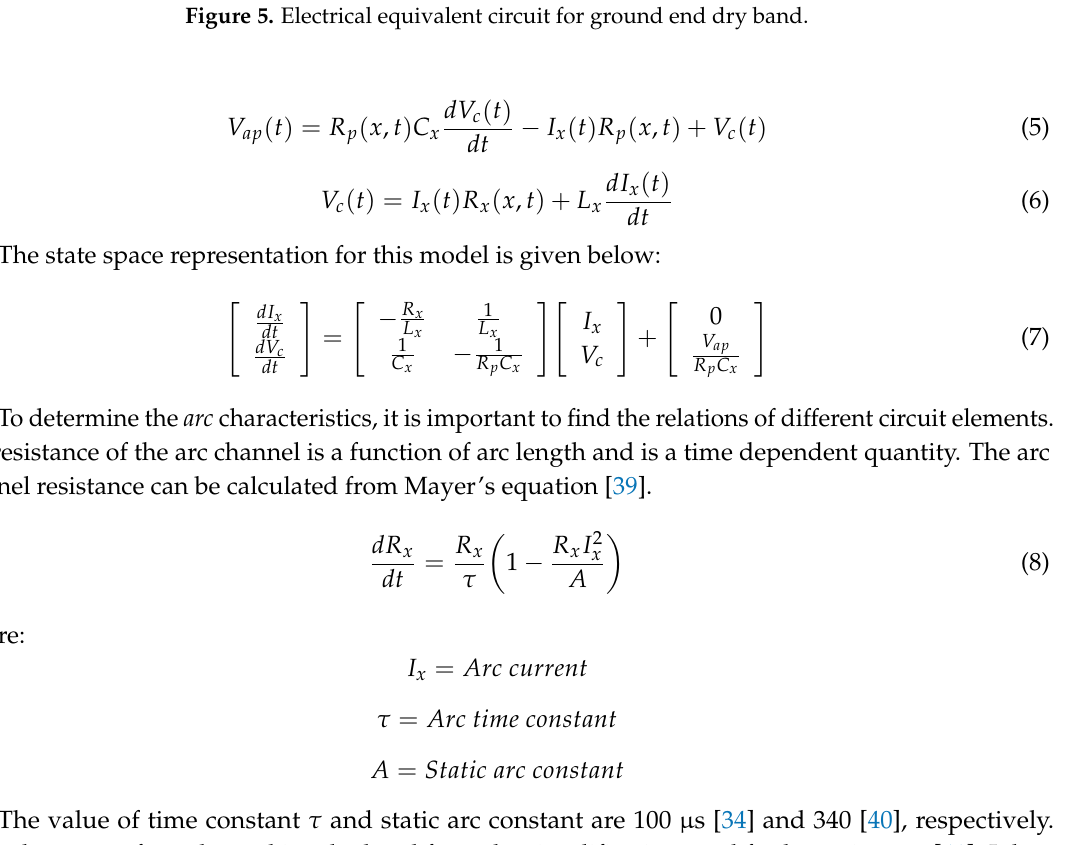
Figure 5. Electrical equivalent circuit for ground end dry